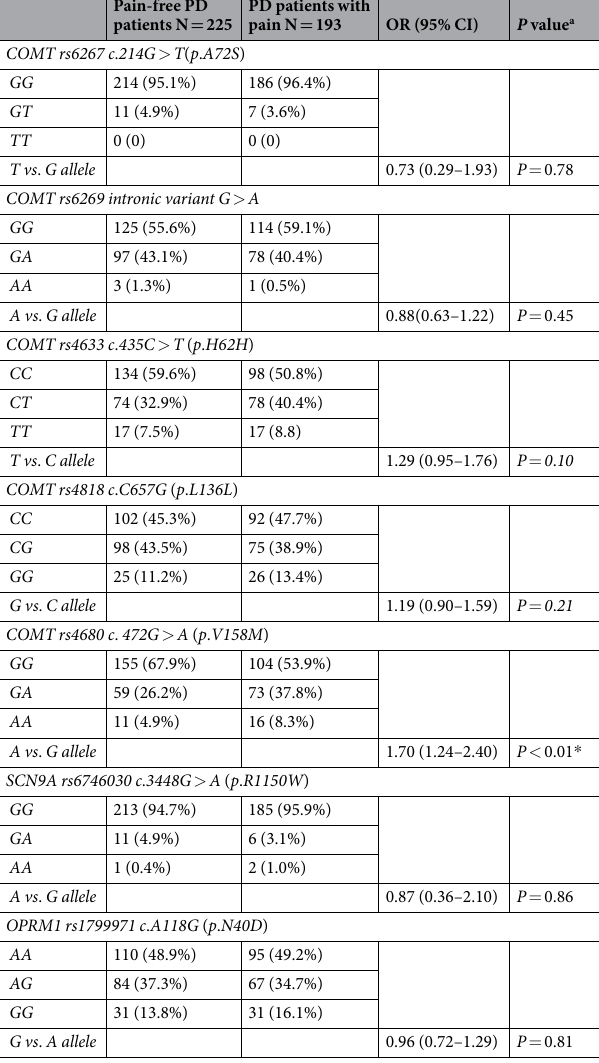
OPRM1 rs1799971 did not differ between PD patients with pain and pan-free patients. Furthermore, because hap- lotypes formed by rs6269, rs4633, rs4818, and rs4680 of COMT gene constituted central COMT locus haploblock that is associated with pain response 15 , we examined whether combinations of alleles (haplotypes) that were formed by the aforementioned four SNPs of COMT affect the susceptibility to pain in patients with PD. Three COMT haploblocks were previously determined in a prior study by linkage disequilibrium analysis 15 . There are two major forms of COMT enzyme: membrane bound and soluble forms. There were three COMT SNPs (rs4633, rs4818 and rs4680) located within the central coding region for both membraneous and soluble forms of COMT. Because the association with pain sensitivity was previously observed for SNPs rs6269 and rs4818, located in the central COMT locus haploblock, in patients with a chronic pain syndrome 15 , we therefore focused our analyses on the haplotype covering this central haplobolck, reflecting the order of occurrence from 5 ′ to 3 ′ in the COMT gene as rs6269, rs4633, rs4818 and rs4680, respectively (Fig. 2). Six haplotypes out of possible 16 were detected from these four SNPs with the most frequent haplotype (Haplotype 1, 24.6%) composed of the most frequent alleles for SNPs rs4633 and rs4680 and the least frequent alleles for SNPs rs6269 and rs4818 (G_C_G_G for SNPs rs6269, rs4633, rs4818 and rs4680, respectively, Fig. 2). The second major haplotype (Haplotype 2, 24.3%) was composed of the most frequent alleles for SNPs rs6269 and rs4818 and the least frequent alleles for SNPs rs4633 and rs4680 (A_T_C_A). The third haplotype (Haplotype 3, 16.1%) was composed of a combination of the most frequent alleles for all SNPs (A_C_C_G). The fourth major haplotype (Haplotype 4, 14.3%) composed of the least frequent alleles for all markers (G_T_G_A). The fifth major haplotype (Haplotype 5, 11.9%) composed of the described alleles of the four markers (A_C_G_G) and the sixth haploptye (Haplotype 6, 1.1%) composed of the described